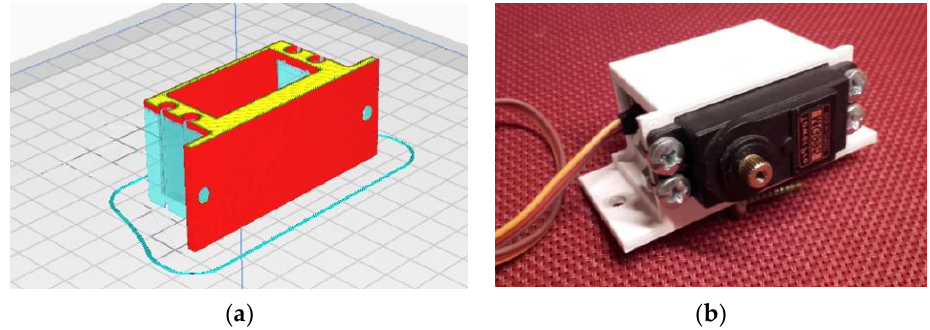
The DC servo motor housing “slice phase” and finished part with built-in servo mo-